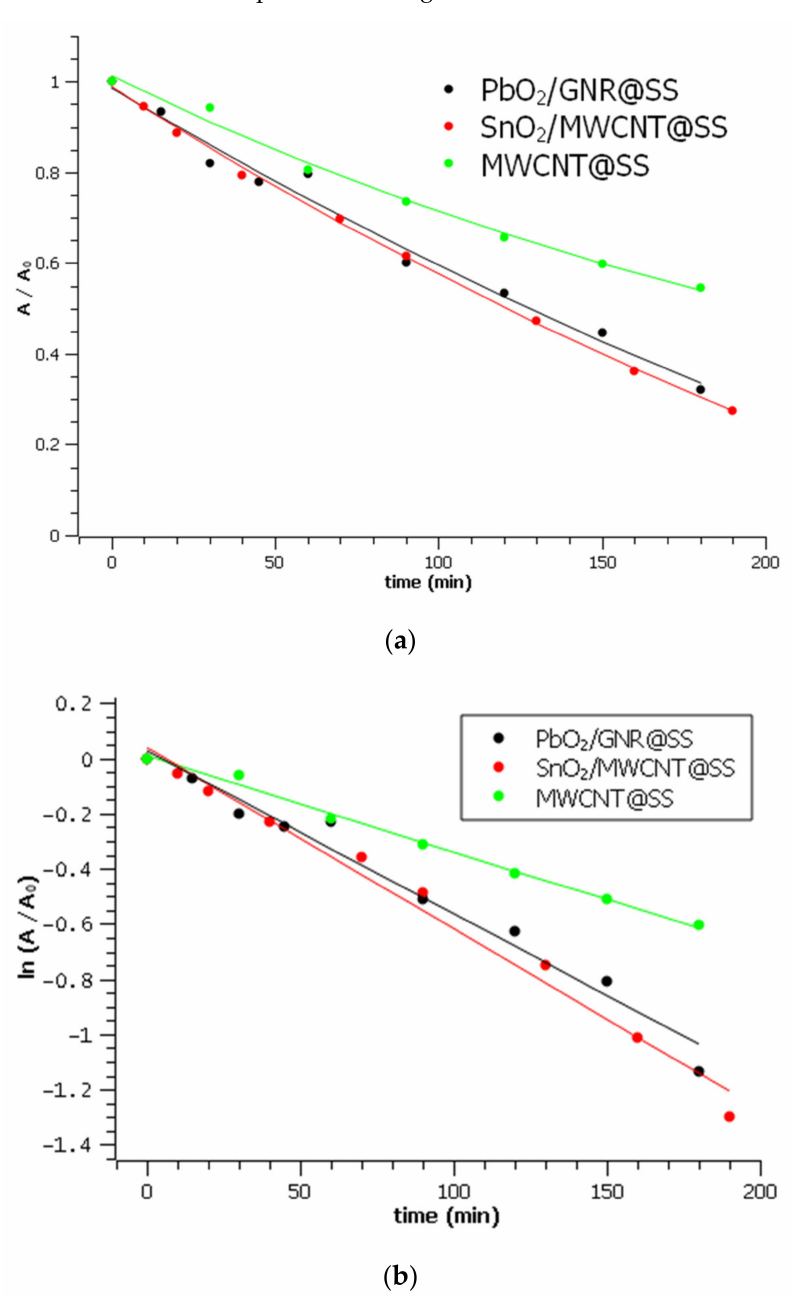
Figure 7. Rhodamine B degradation on three investigated electrodes: ( a ) Degradation curves. A 0 is the absorbance of Rhodamine B in 0.1 M Na 2 SO 4 at 554 nm before the electrolysis ( b ) linearized forms of degradation curves with calculated k app